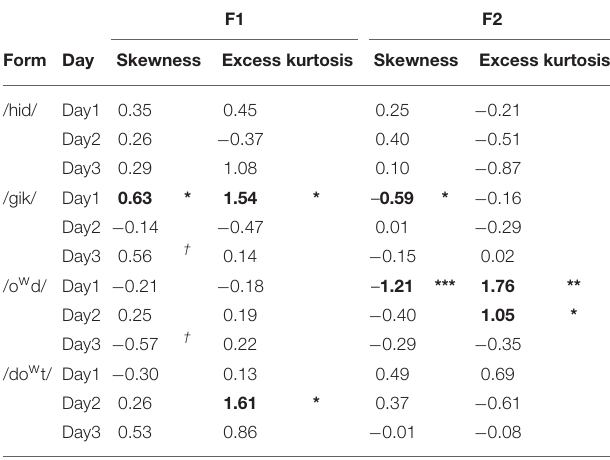
TABLE 2 | Moment coefficients of skewness and excess kurtosis (the fourth moment minus 3) for F1 and F2 measured at the vowel midpoint. F1